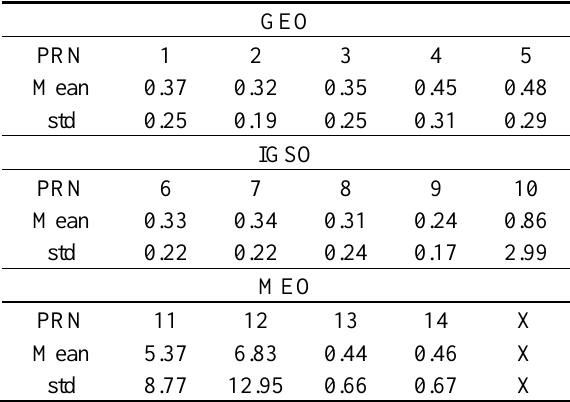
Table 3. BDS DQA1 statistical results.